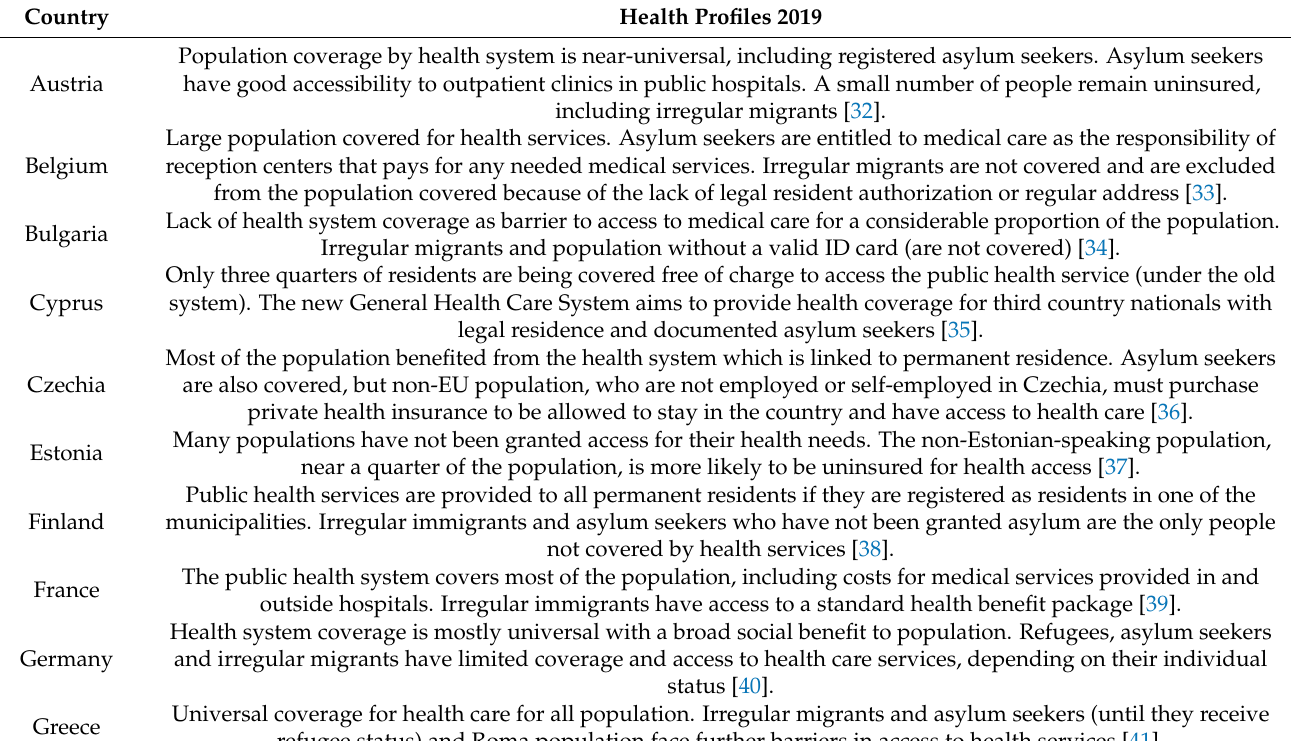
Table 4. Migrant health care access in European Union countries (EU28).